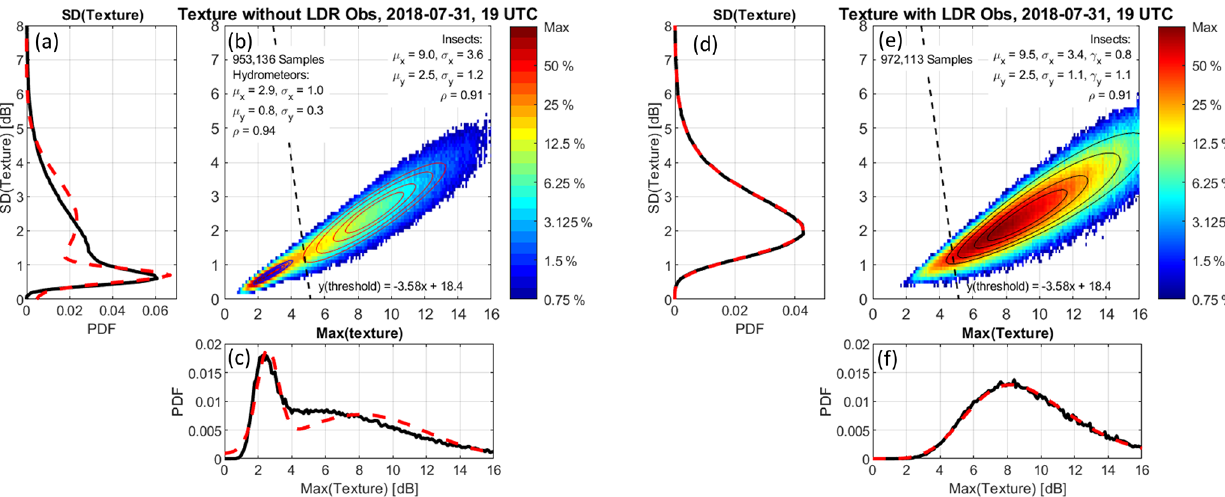
Figure 7. 1D and 2D distributions of texture statistics from hour 19:00UTC on 31 July 2018. Panels (a) – (c) are 953136 spectra regions without LDR detected and panels (d) – (f) are 972113 spectra regions with LDR detected. (a) 1D PDF of SD(texture). The black line is observations and the red dashed line is fit to two Gaussian distributions. (b) Colors are the observed 2D distribution of SD(texture) vs. Max(texture). Colors represent the percentage of occurrence relative to the cell with the maximum number of observations. Blue and red contours are 2D Gaussian fits to hydrometeors (blue) and insects (red). Contours represent 90%, 75%, 63%, and 50% occurrence. Gaussian fit parameters are displayed in panel (b) . The threshold between hydrometeor and insect is indicated by the dashed black line. (c) 1D PDF of Max(texture). The black line is observations and the red line is fit to two Gaussian distributions. (d) Similar to (a) except for spectra regions with detected LDR. (e) Similar to (b) except there is only one distribution caused by insect scattering. Contours are 2D generalized Gaussian fits. (f) Similar to (c) except the red curve is fit to one generalized Gaussian distribution.